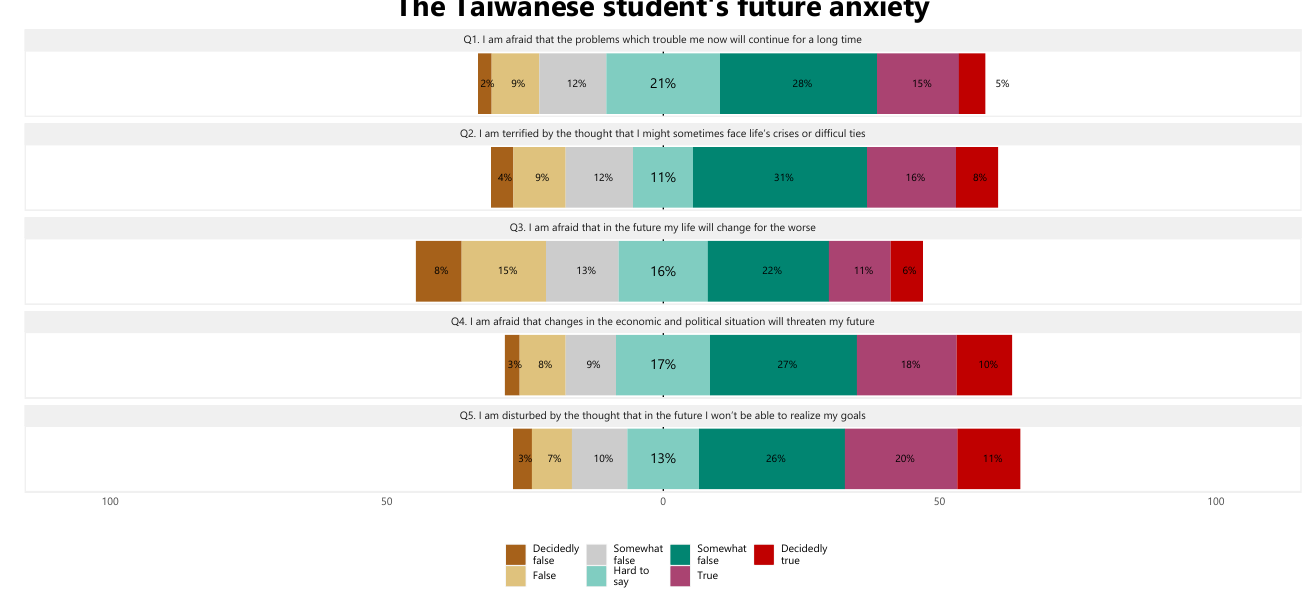
Figure 4. The distribution of FA questions among the Taiwanese university students. Table 3. Associated factors of future anxiety via linear regression models ( n =